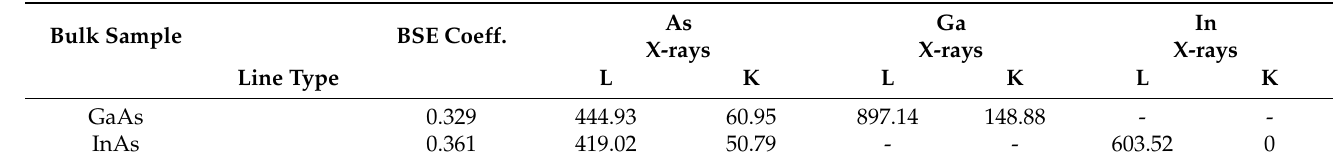
Figure 6. Three long specimens of InGaAs/GaAs (numbers # 1–3) and one small piece of InAs substrate (sample # 4) mounted on a 1” diameter SEM stub ( a , b ); BSE image of central area where all samples are visible, as used for SEM-EDXS ( c ). Specimen numbers correlate with those in Table 3. Table 2. Monte Carlo simulation of backscattered electron (BSE) yield and characteristic X-ray intensities of L- and K- lines for bulk substrates at 15 kV.